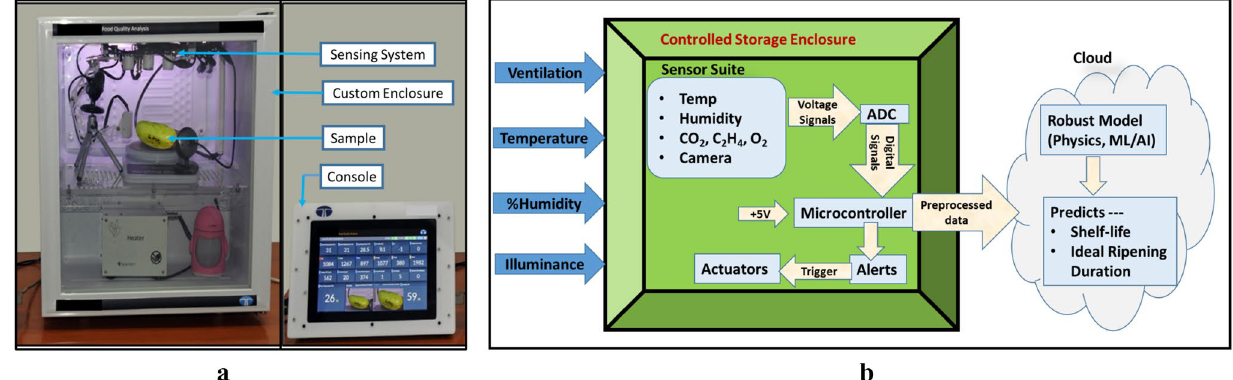
Fig. 1 a IoT and Cloud enabled sensing system and temperature controlled custom enclosure. b Schematic representation of the overall